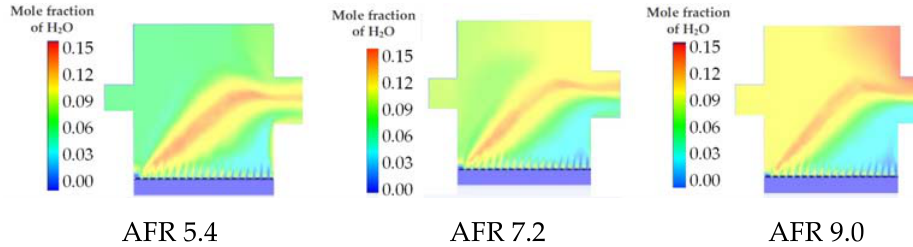
Figure 11. Contours of CO 2 concentration.